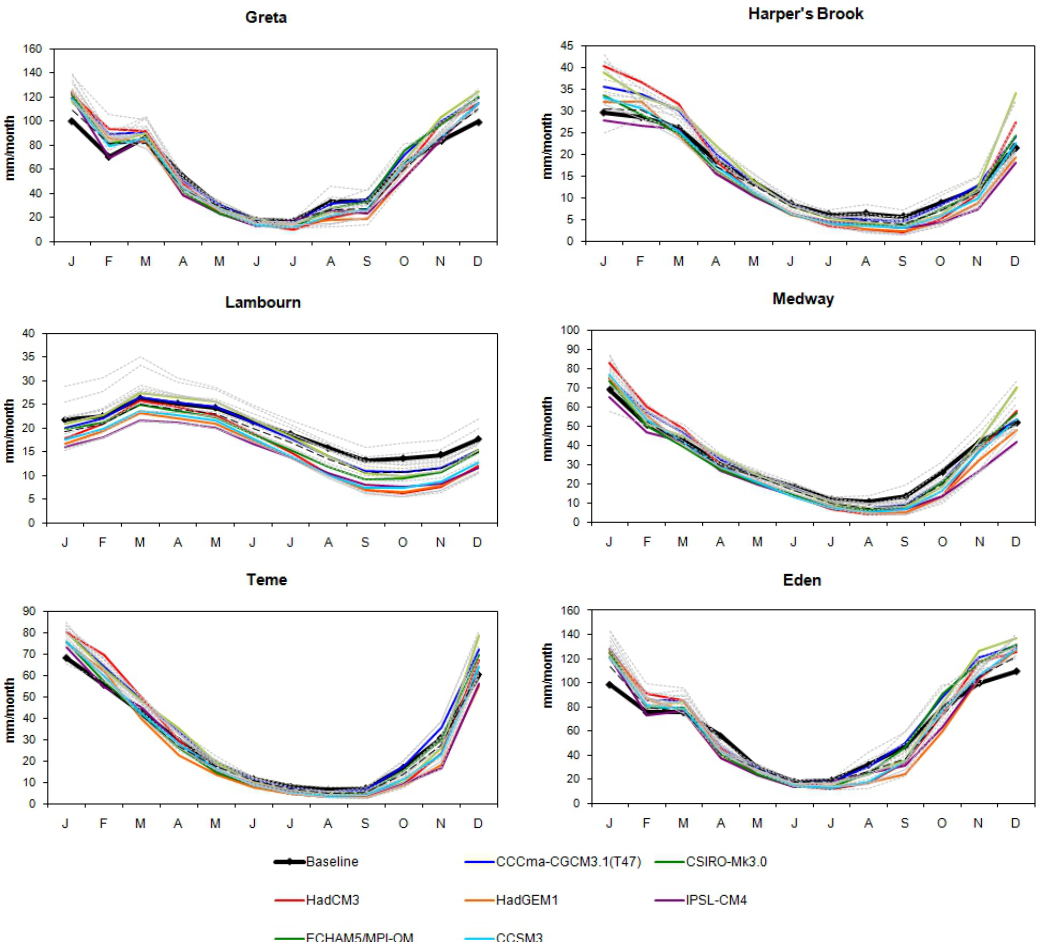
Fig. 4. Mean monthly runoff for each catchment, under the baseline climate and with a 2 ◦ C rise in global mean temperature. The seven priority scenarios are